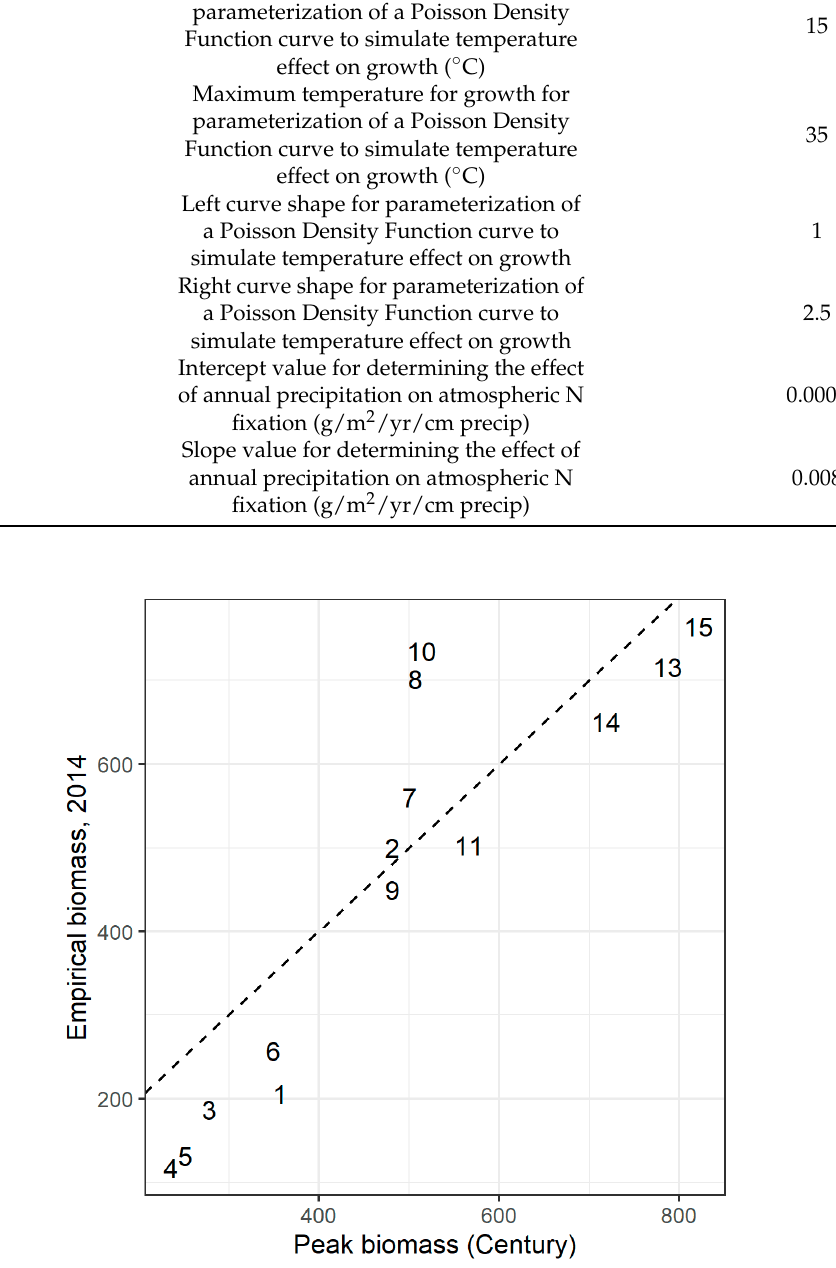
Table A3. Model parameters that were calibrated with comparison to empirical biomass and NDVI. The same parameter values were used for simulations using Century and RPM.